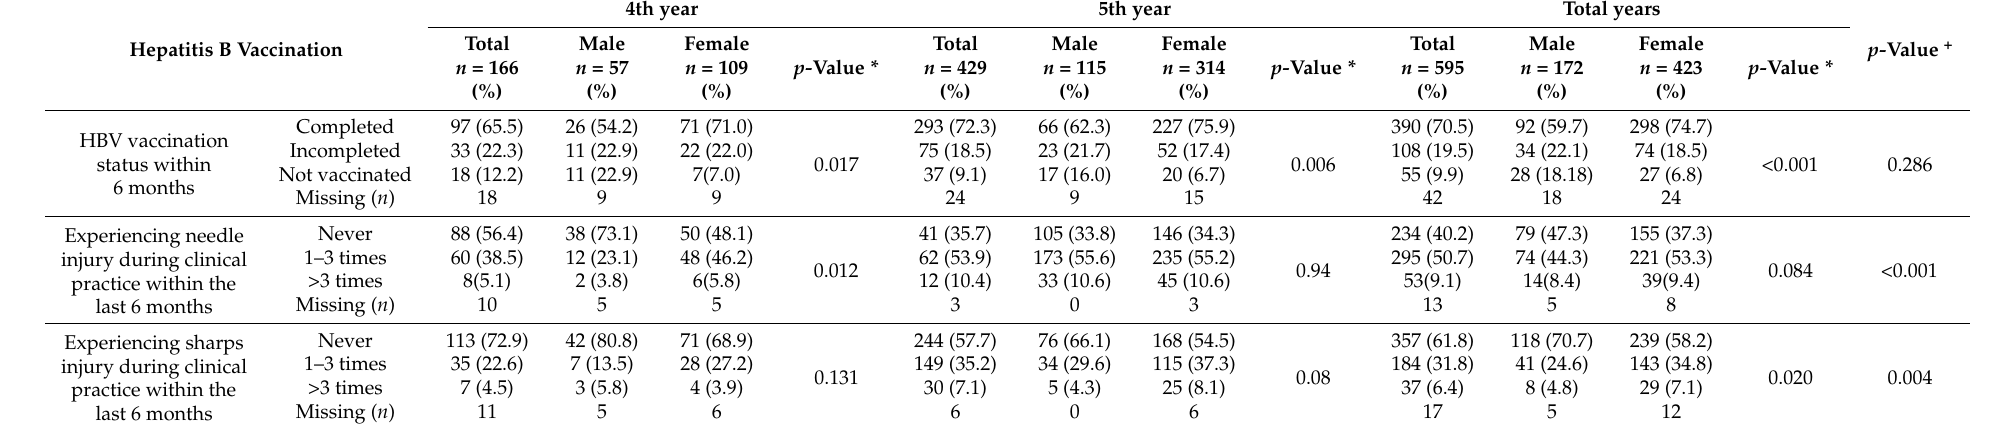
Table 3. HBV vaccination, needle injury, and sharps injury experiences among the fourth- and fifth-year students in four Egyptian public dental schools.